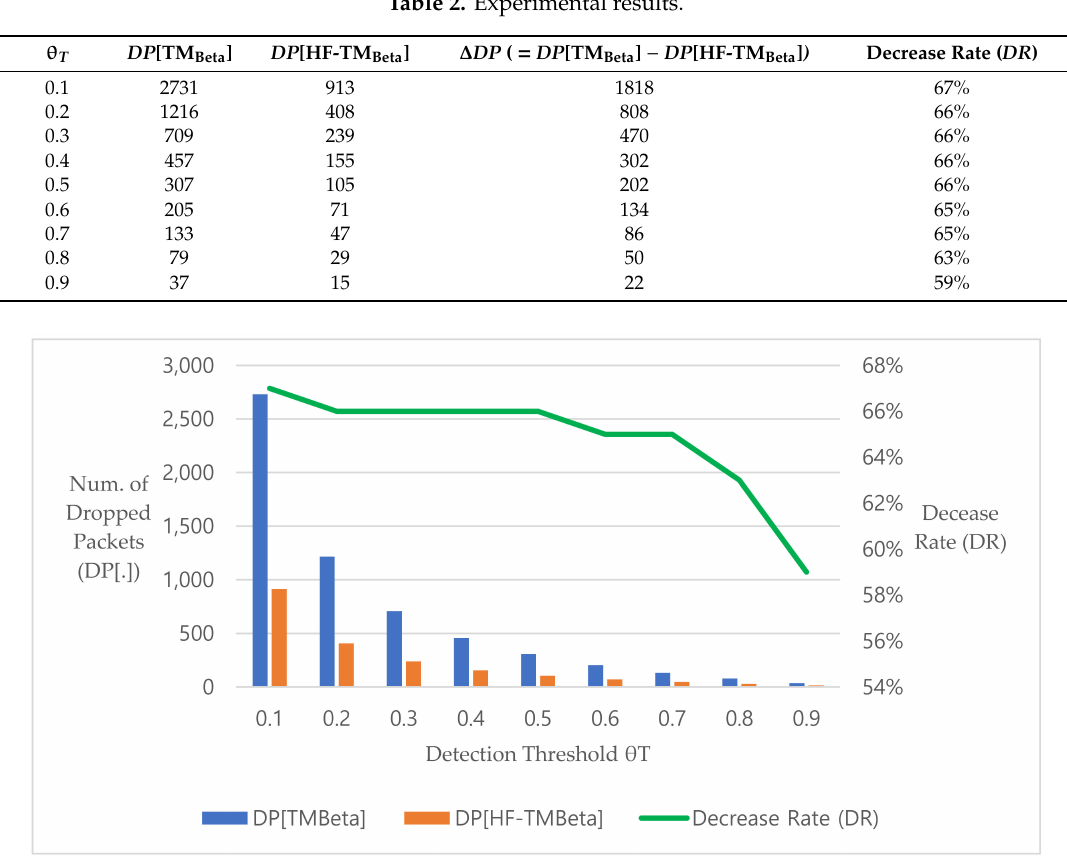
Table 2. Experimental results.